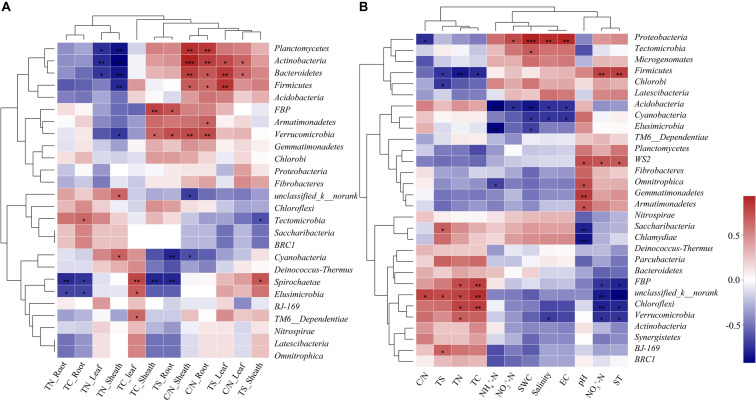
Correlation heat map of the top thirty phyla and soil properties and vegetation. X and Y axis are environmental factors and phyla. R in different colors to show, the right side of the legend is the color range of different r values. *P < 0.05; **P < 0.01; and ***P < 0.001. Phyllosphere and rhizosphere bacterial communities are shown in (A, B), respectively.